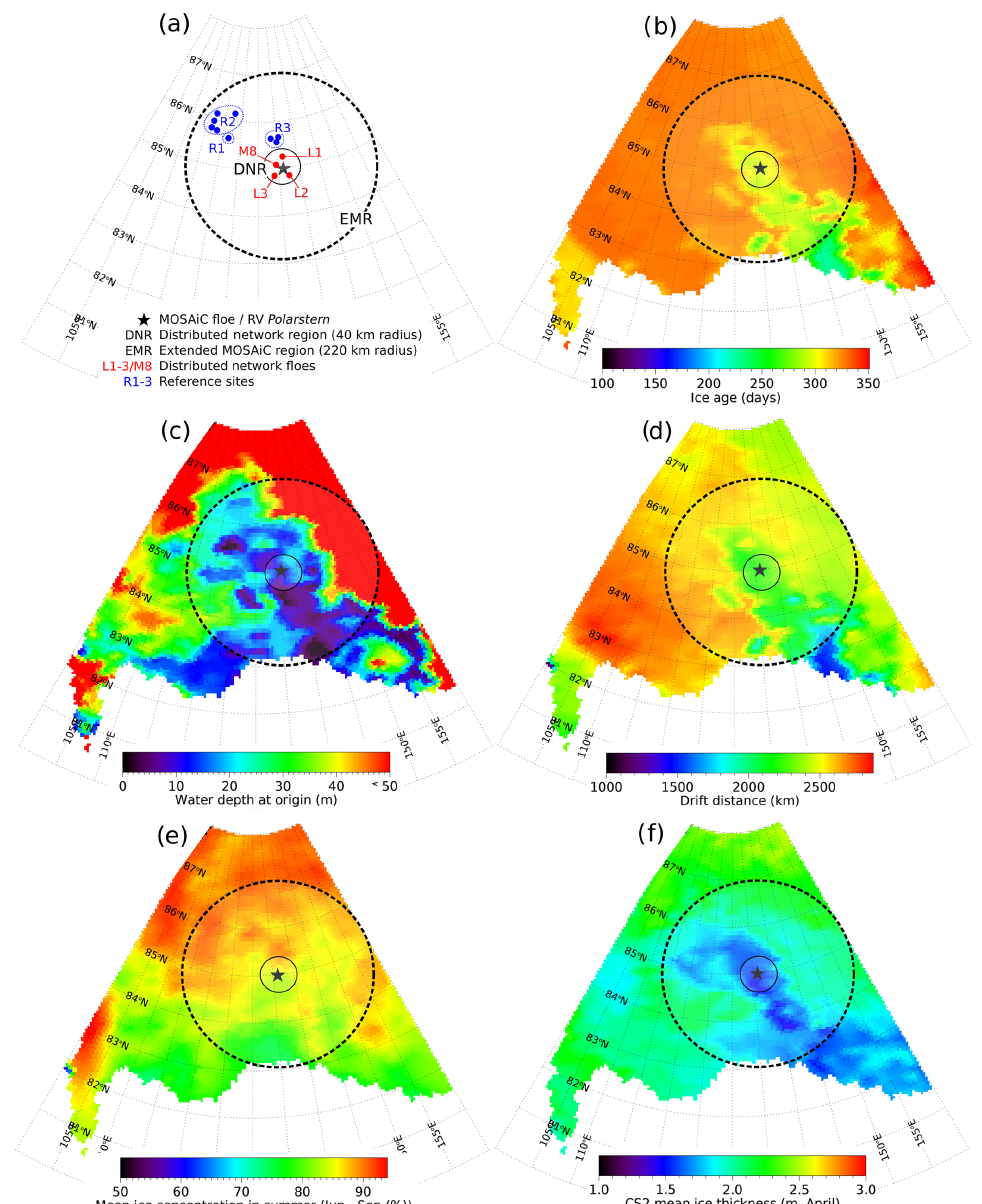
Figure 3. Results of Lagrangian sea ice backward tracking (see Methods). (a) Starting point of the MOSAiC expedition (black star: position of the Central Observatory), the spatial extent of the investigation areas defined in this paper (DNR and EMR), and the reference sites where additional ice and snow thickness measurements were obtained. (b) Sea ice age at the start of the MOSAiC expedition on 25 September according to Lagrangian tracking. (c) Water depth at the ice formation site for each tracking position. (d) Average distance of sea ice travelled from its formation site to its position on 25 September. (e) Sea ice concentration for each individual point, averaged over the first 3 months (June–September) of tracking along its trajectory. (f) CryoSat-2 ice thickness estimates in late April, along the trajectory of each